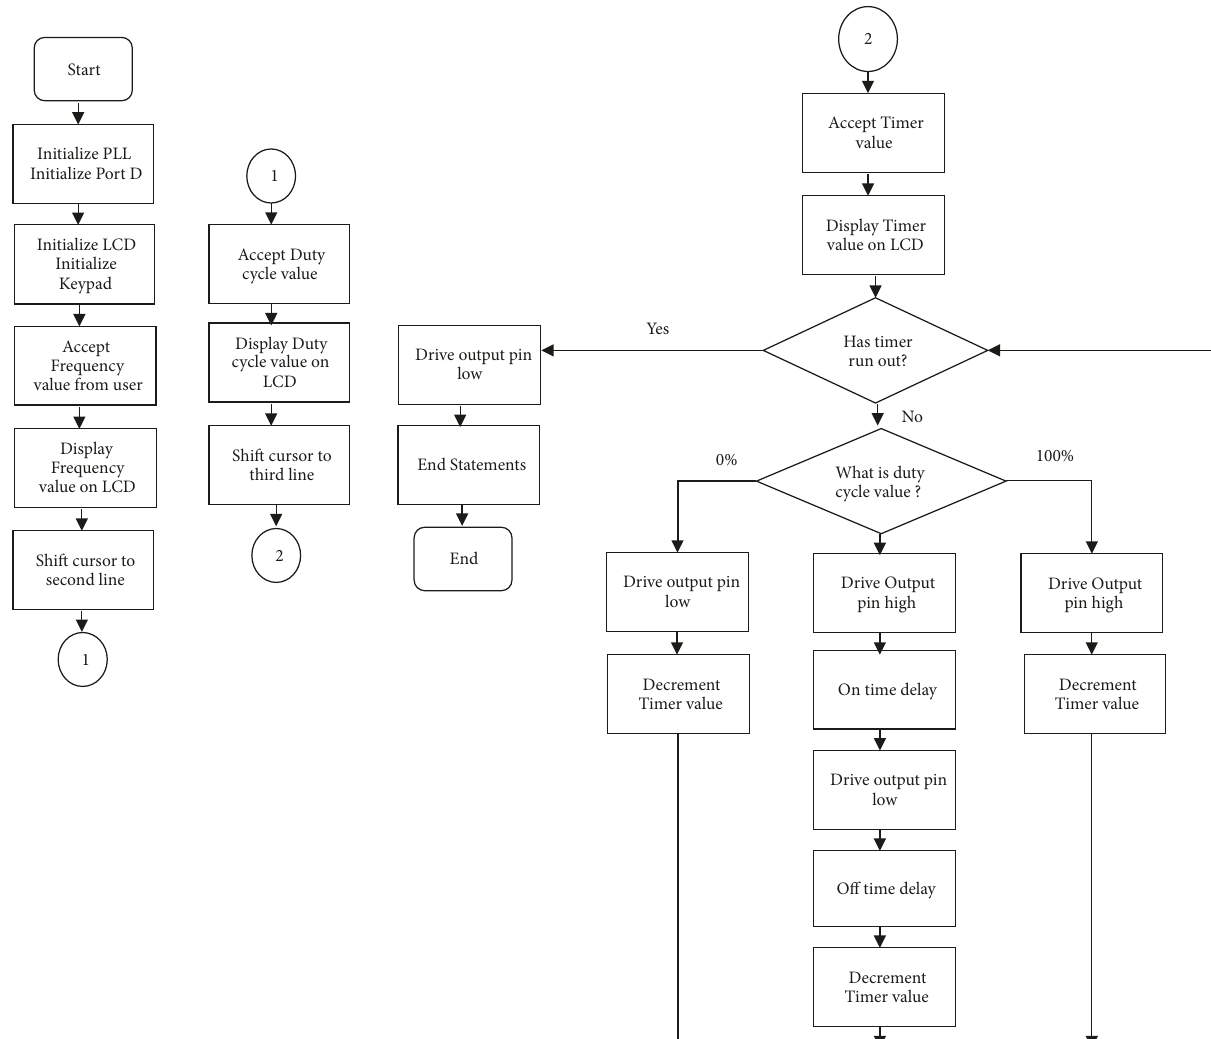
Figure 2: Flowchart representing the algorithm of software design of pulse generator unit of LED based phototherapy